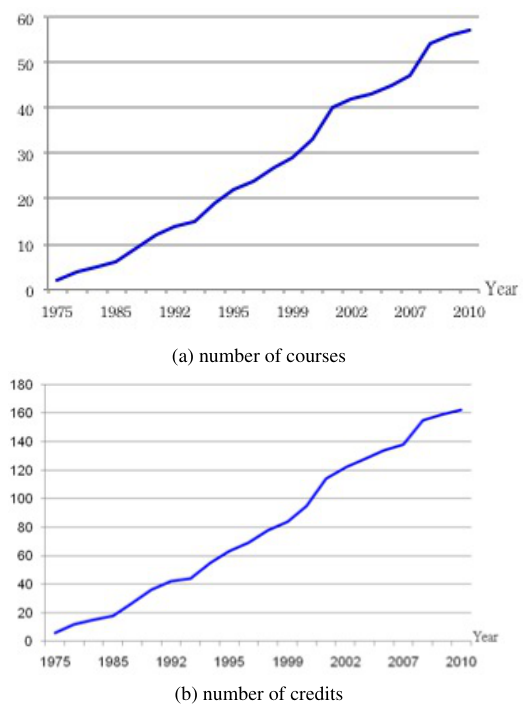
Figure 3: Number of undergraduate courses and credits